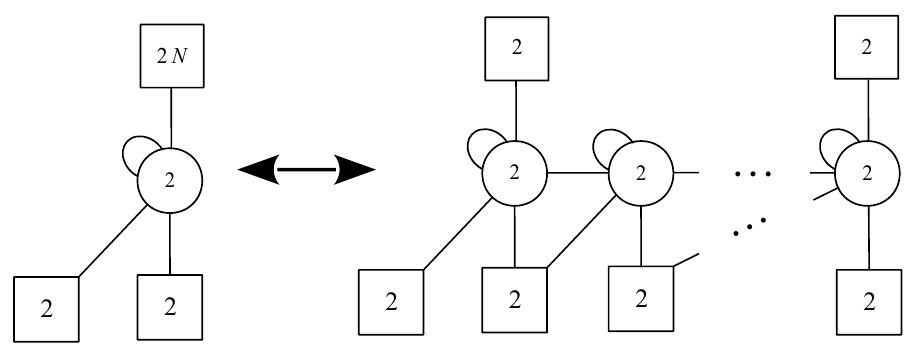
[USp(2 N )] and E [ N (cid:0) 1 ; 1] [USp(2 N [ N (cid:0) 1 ; 1]